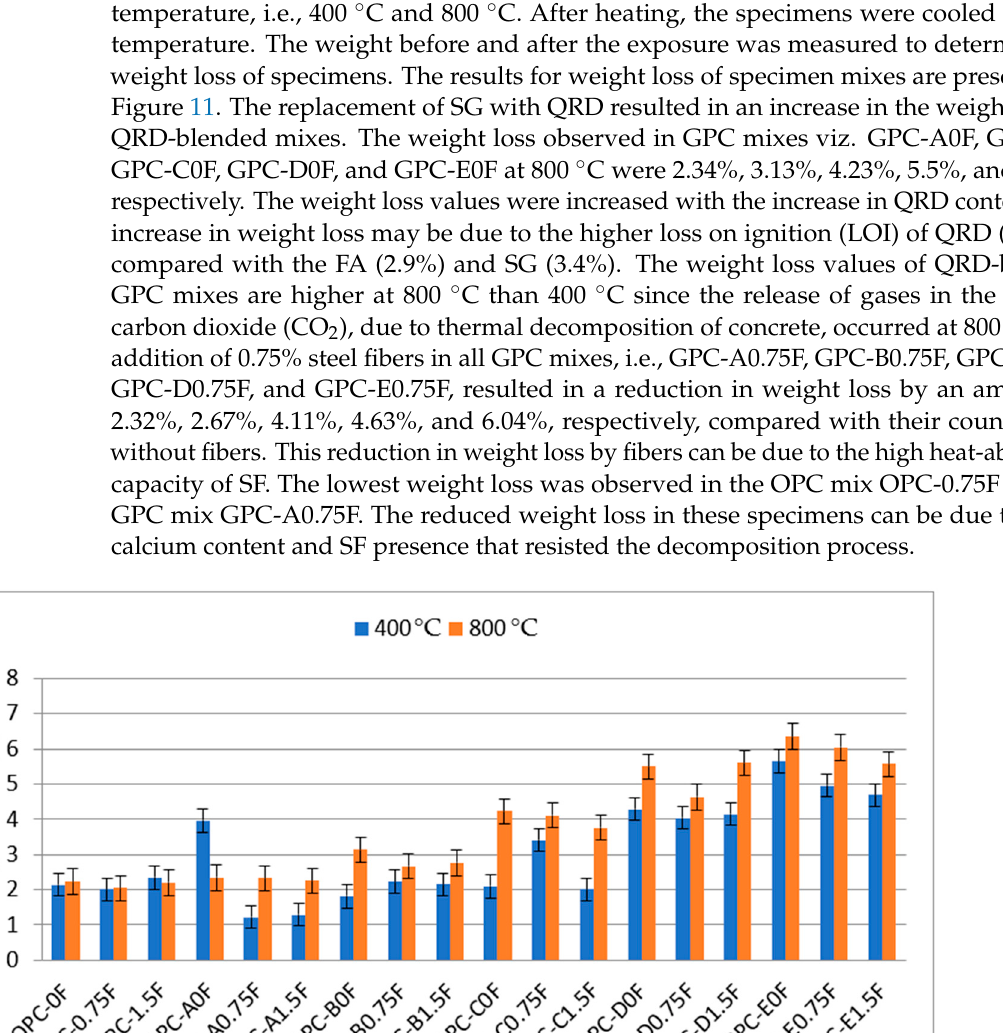
Figure 11. The weight loss values of GPC and OPC mixes after heating the specimens at elevated temperature. The residual compressive strength of OPC and GPC mixes was investigated to be inversely proportional to the temperature and QRD content. The compressive strength of all plain GPC mixes viz. GPC-A0F, GPC-B0F, GPC-C0F, GPC-D0F, and GPC-E0F at 400 °C were decreased by 9%, 13%, 23%, 31%, and 33%, respectively, from the compressive strength at room temperature as shown in Figure 6. The strength of the OPC control mix OPC-0F at 400 °C was decreased by 60%, indicating that GPC mixes are more fire-resistant than the traditional OPC mixes at 400 °C. It can also be seen from Figure 12 that the resid- ual strength of QRD-blended mixes decreased with the increase in QRD content. 01